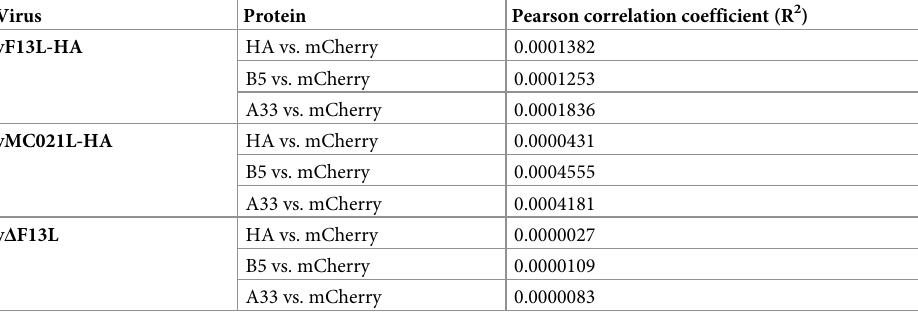
Table 1. Correlation of EV protein signal with mCherry